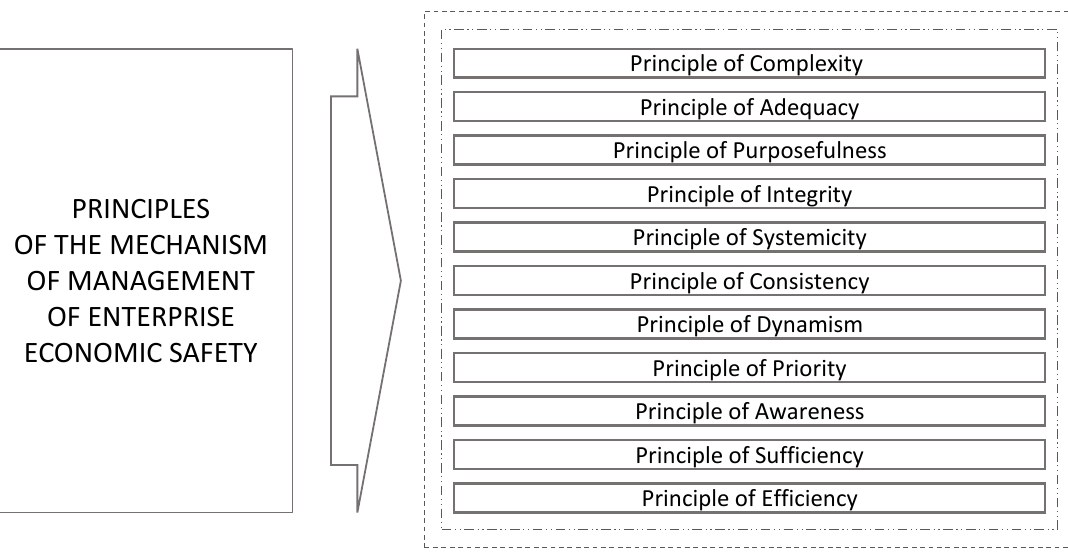
Figure 2. Basic principles of the mechanism of the enterprise economic security management